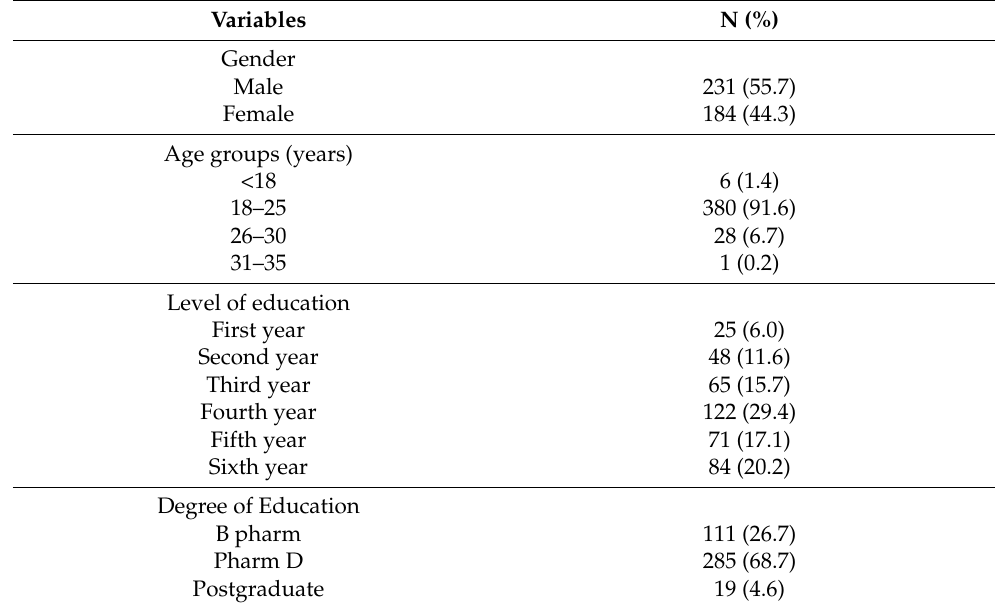
Table 1. Demographic data of